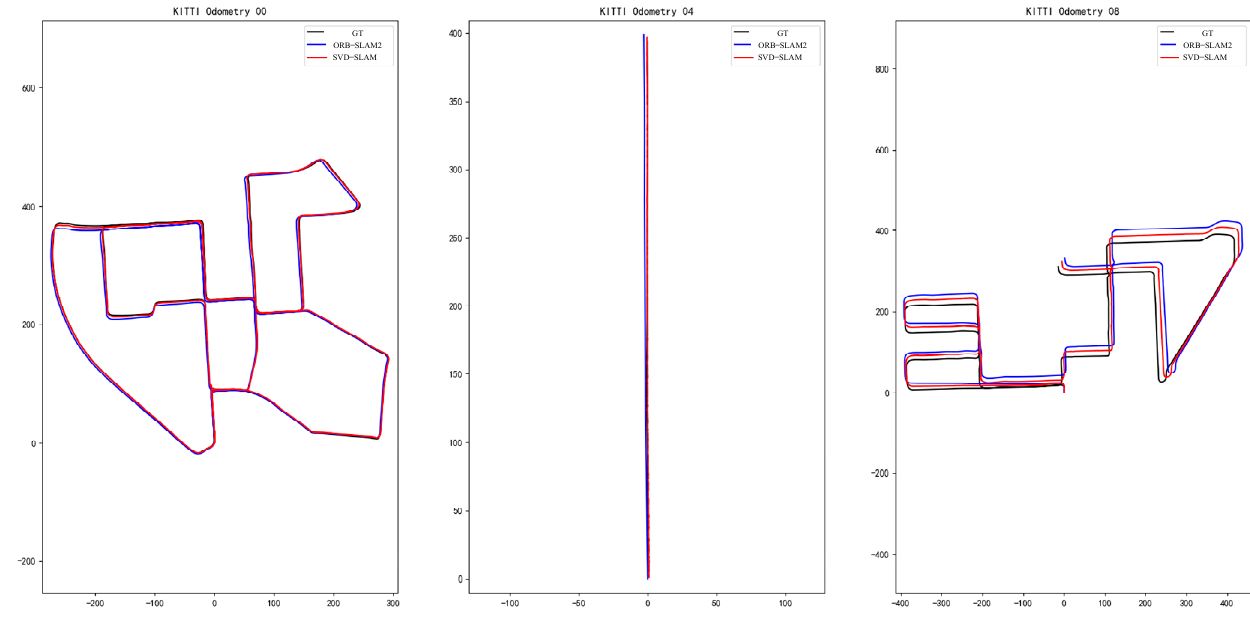
Figure 4. Comparison of trajectory estimation results for sequences 00, 04, 08. Absolute pose error (ATE) and relative pose error (RPE) were utilized to evaluate the positioning accuracy of the algorithm and compare it to the enhanced ORB-SLAM. ATE